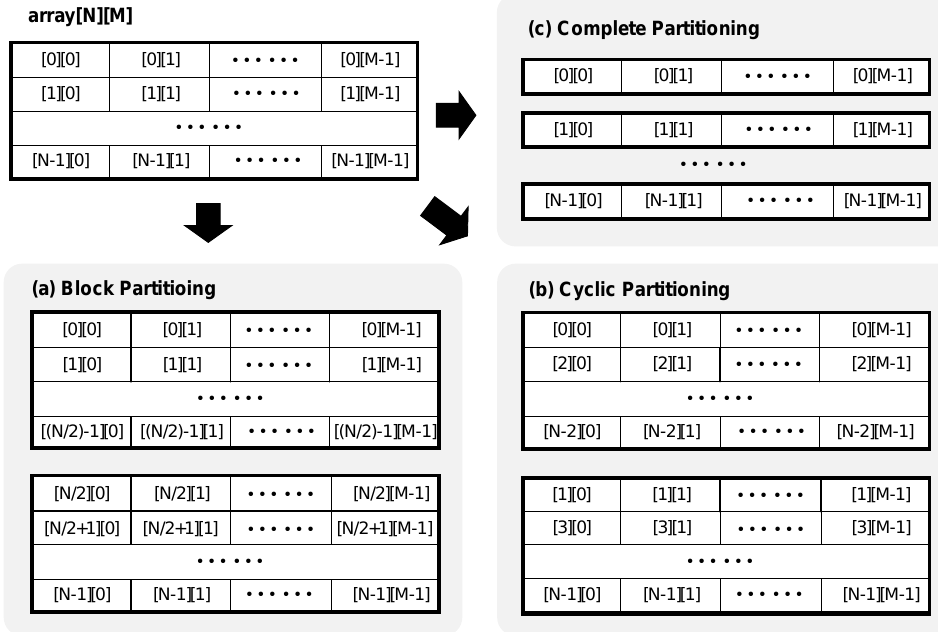
Figure 3. Different types of array partitioning techniques; block, cyclic, and complete partitioning. (2) Loop Unrolling: Loop unrolling shortens loop execution time by reducing the number of iterations of the loop. Loop unrolling enables parallel execution of independent operations by generating multiple copies of the loop body. For example, as shown in Figure 4, the number of loop iterations is N in the original code, whereas after loop unrolling is applied, it is reduced to N . However, redundant code generated by loop unrolling causes 4 the overhead of increasing the code size and required registers.